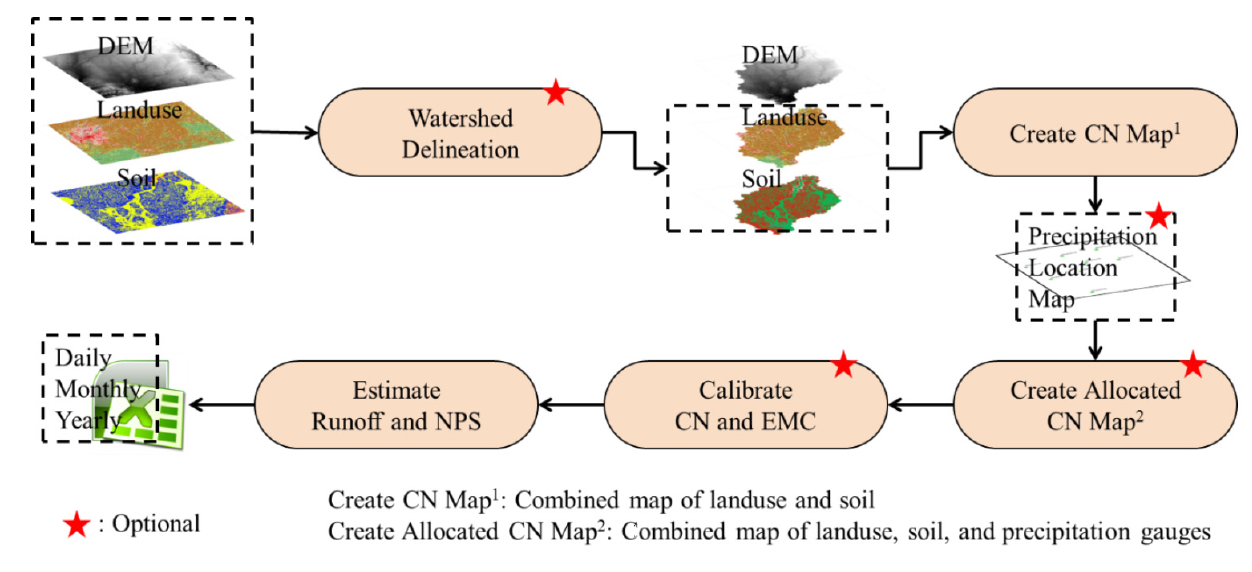
Figure 5. Overview of GIS L-THIA application